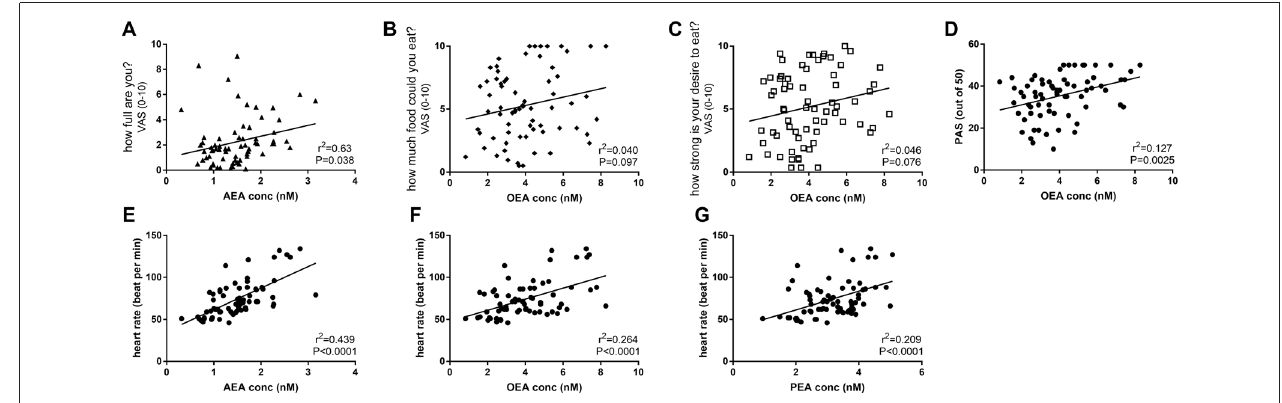
FIGURE 5 | Correlations between plasma eCBs levels and appetite (A–C) , mood (D) and HR (E–G) in healthy female volunteers when measured pre or post-activities and analyzed by linear